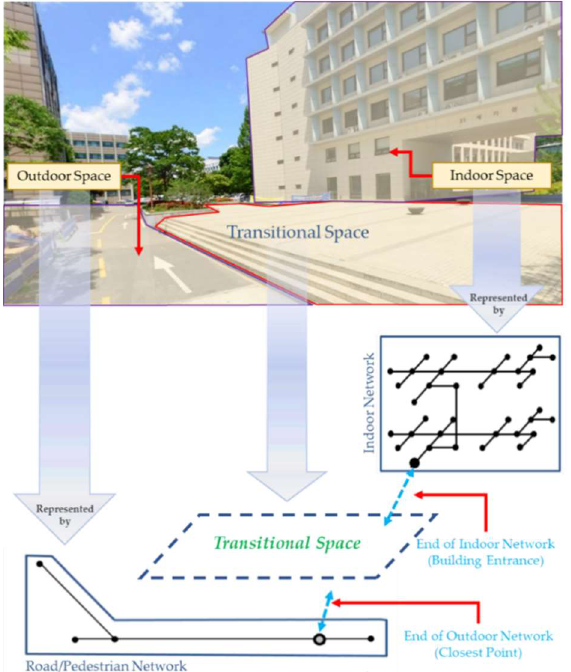
Figure 4. Transitional space existing between indoor and outdoor space.